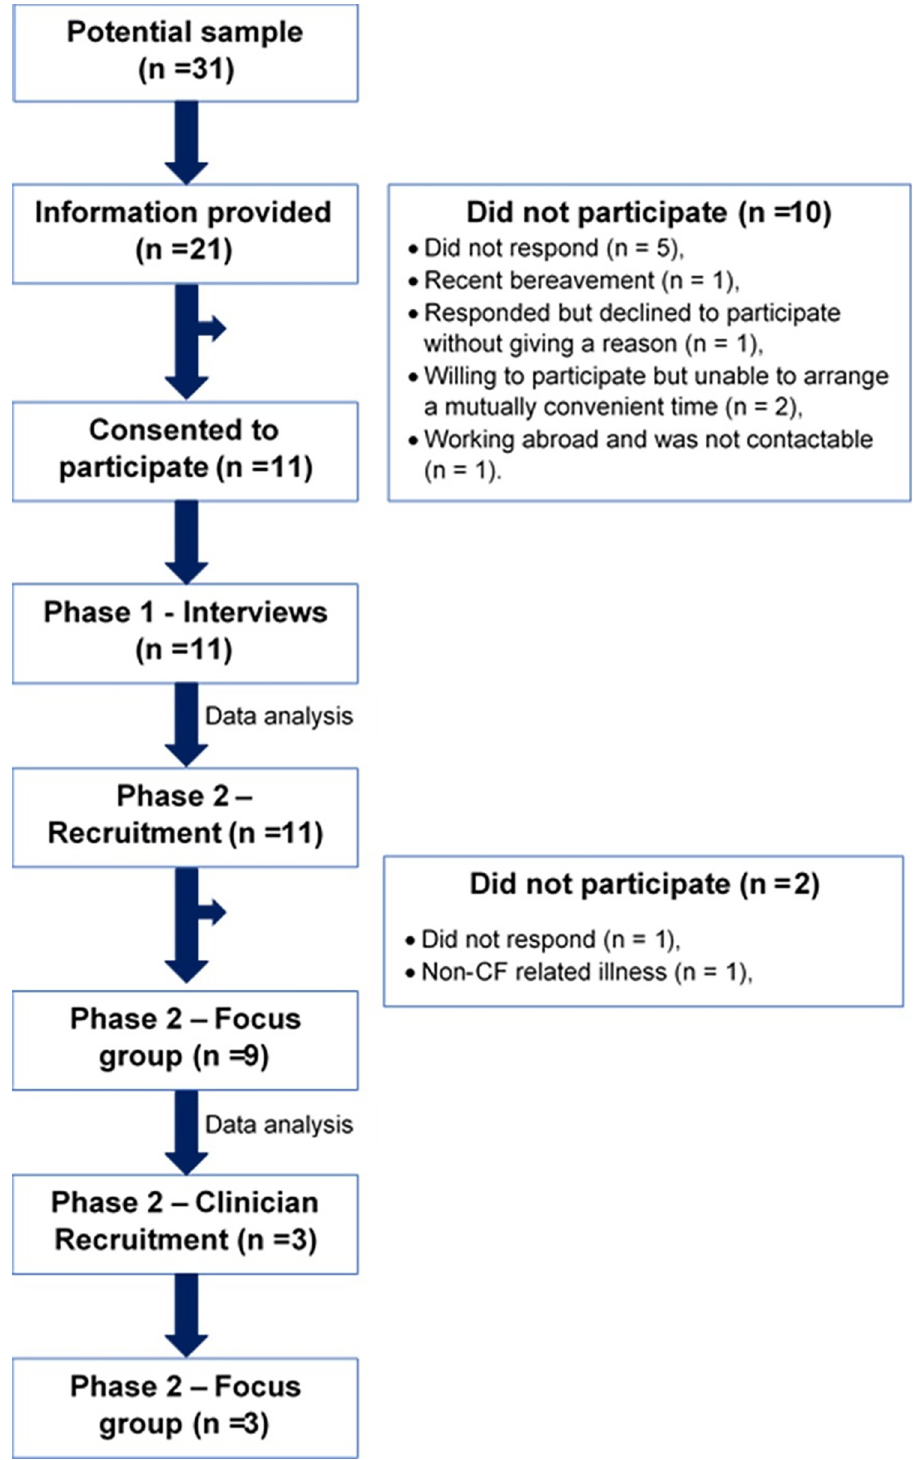
Fig 1. Illustrating the iterative process from participant screening and recruitment to data collection and analysis.